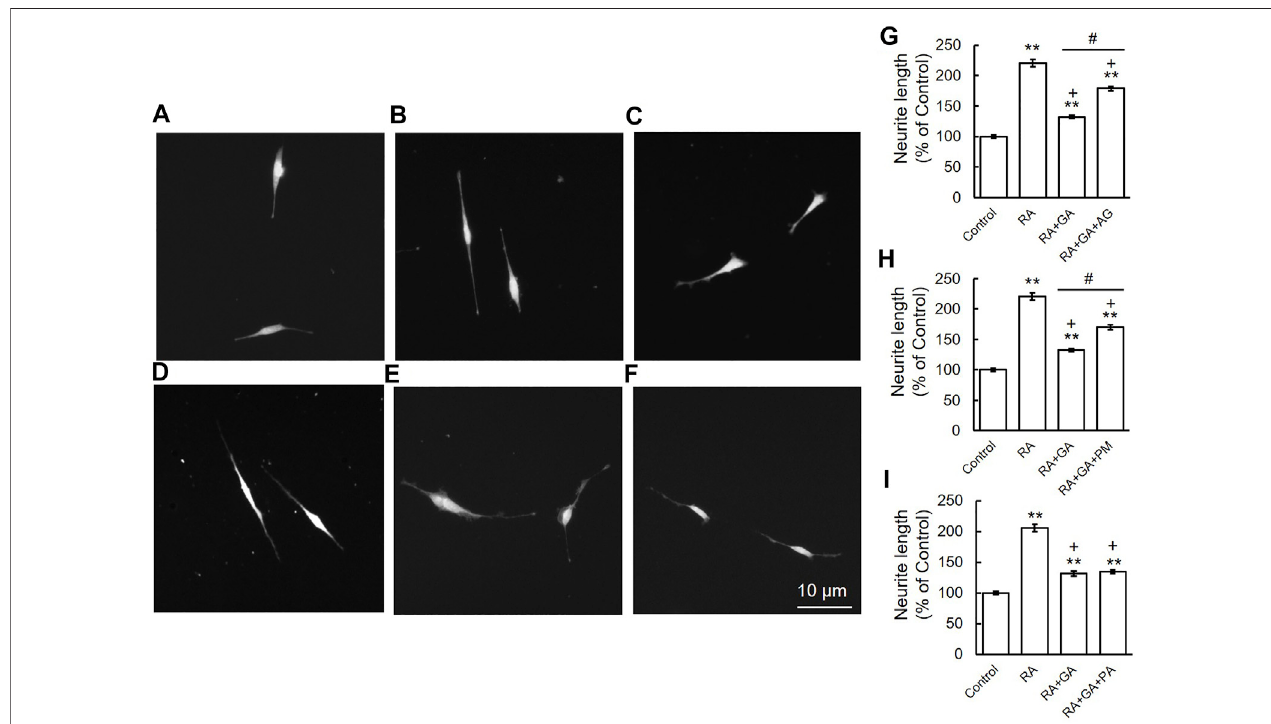
FIGURE6| AGorPMbutnotPArecoveredtheinhibitionofneuriteoutgrowthbyGA. (A – F) PhotomicrographsofRA-inducedneuriteoutgrowthinSH-SY5Ycells. (A) Vehicle control, (B) RA-treated cells, (C) RA + GA, (D) RA + GA + AG, (E) RA + GA + PM and (F) RA + GA + PA. Scale = 10 μ m. (G – I) Quanti fi cation of neurite outgrowth. ** p < 0.01 vs. vehicle control, + p < 0.01 vs. RA alone, # p < 0.01 vs. RA plus GA ( n = 100).